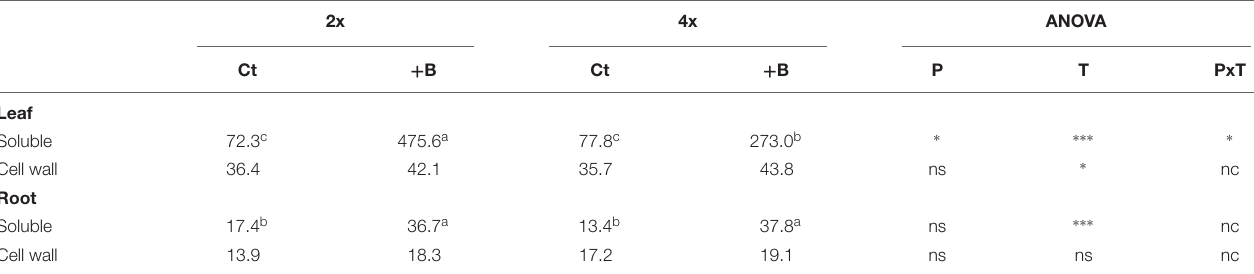
Values are the means of six plants (n = 6). Ploidy (P) and treatment (T) effects tested by two-way ANOVA are indicated as follows: ∗ P < 0.05; ∗∗∗ P < 0.001; ns, not significant; nc, not considered. Different letters in rows indicate significant differences at P < 0.05 using Duncan’s multiple range test.